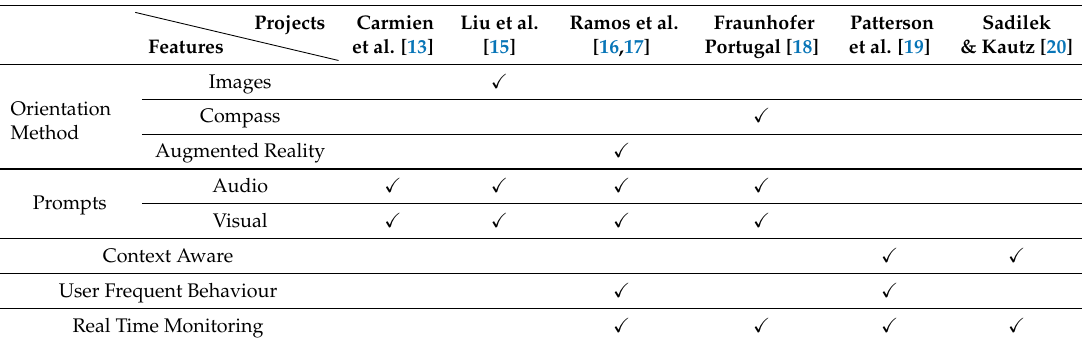
Table 1. System features covered by exintings projects.